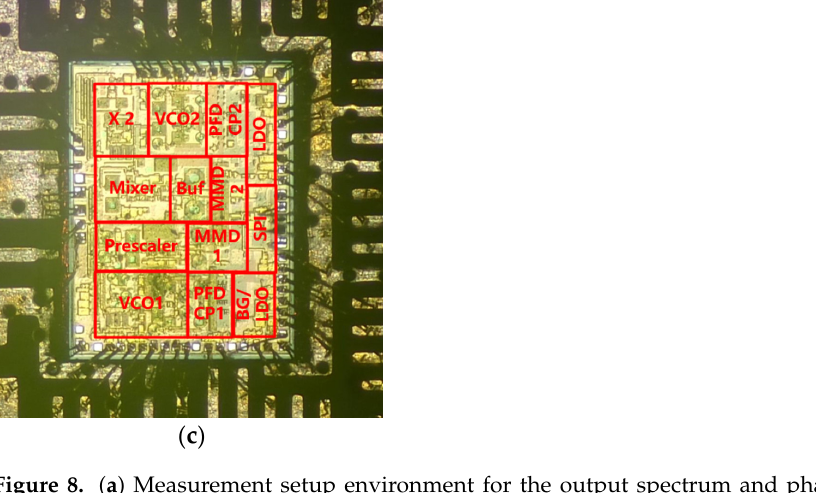
Figure 8. ( a ) Measurement setup environment for the output spectrum and phase noise of the dual-loop dual-output synthesizer chip; ( b ) photograph of the wire-bonded dual-loop dual-output frequency synthesizer chip; ( c ) function module blocks in the chip.